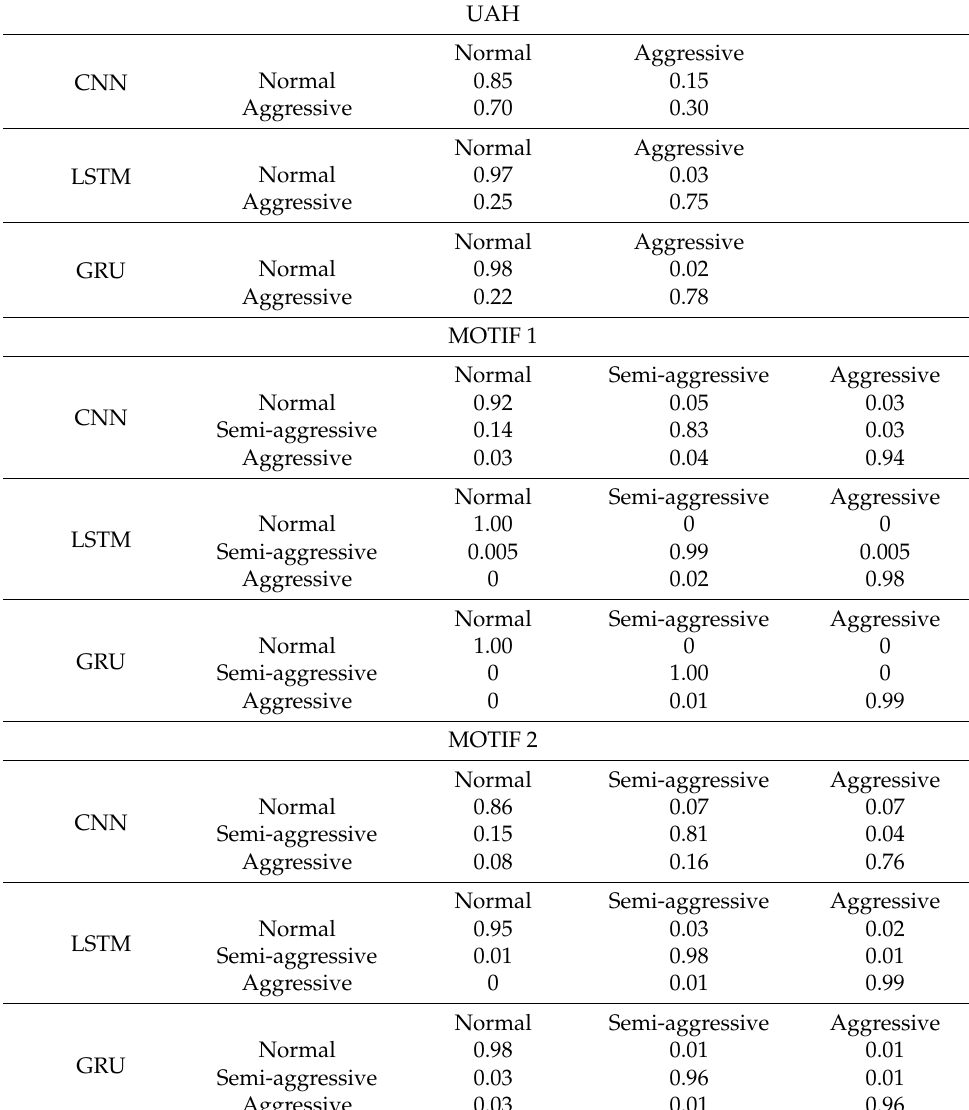
Table 4. Confusion matrices for time slice